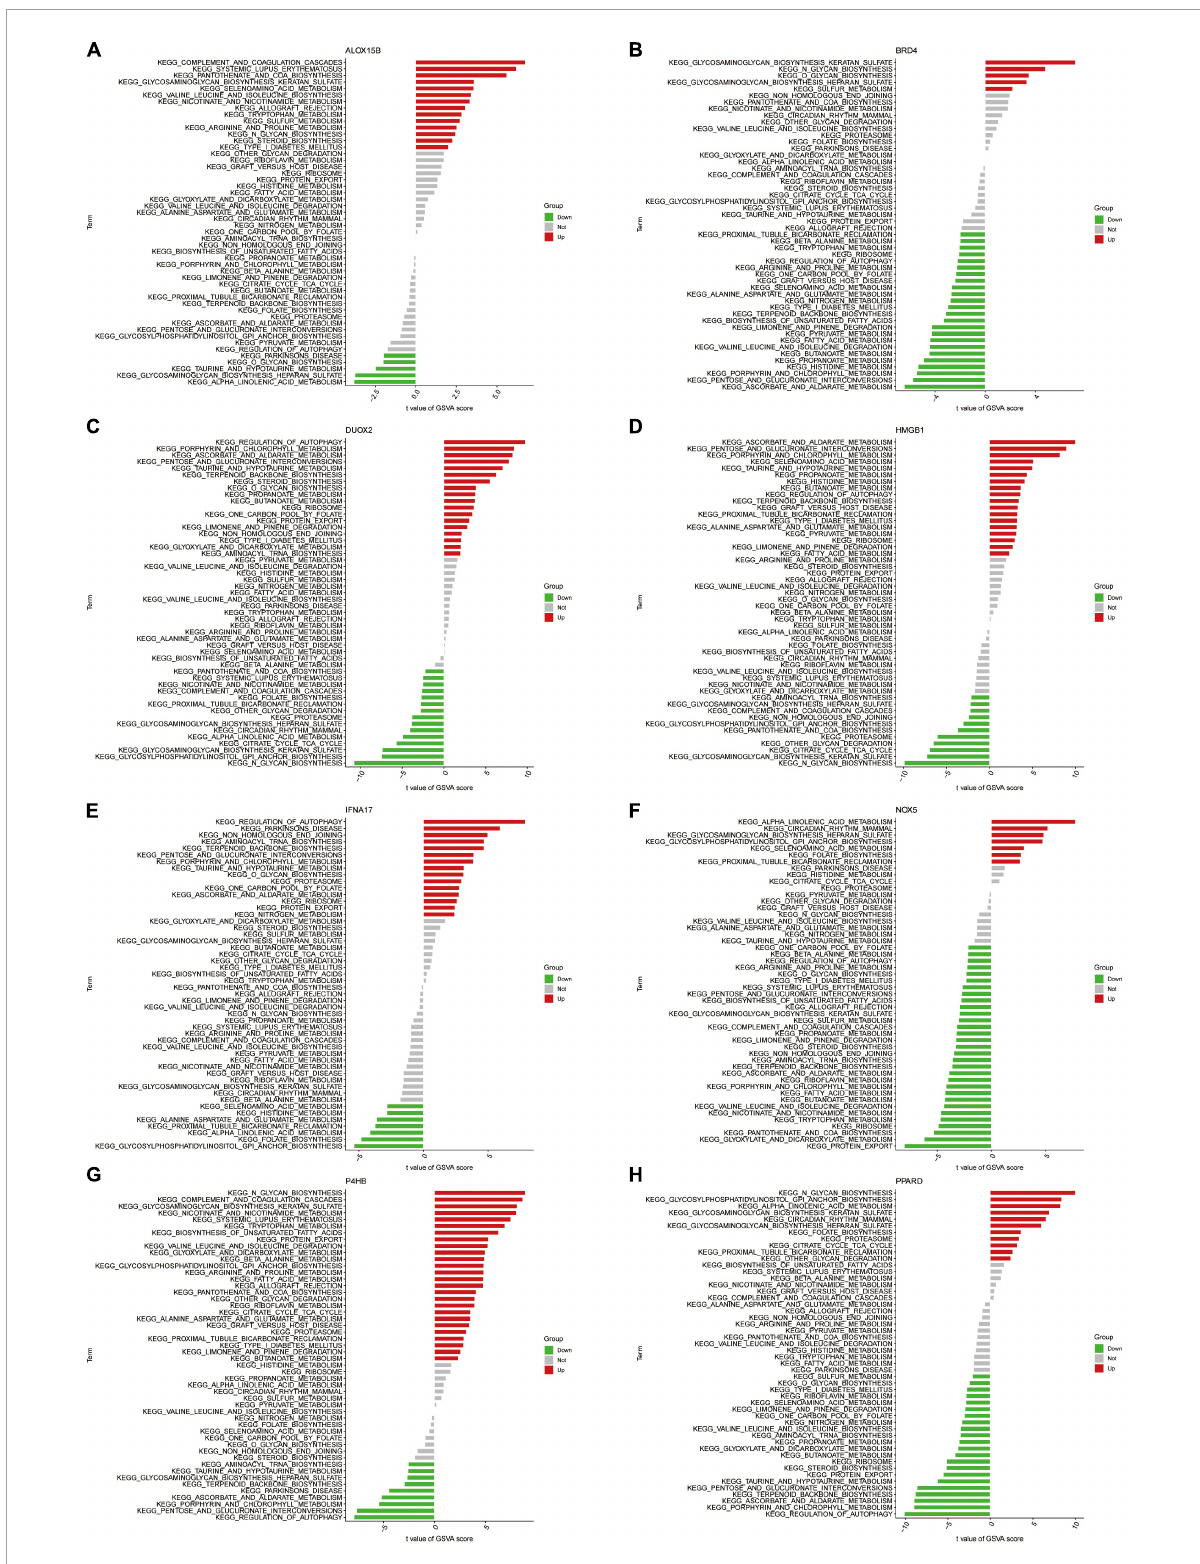
FIGURE10 (A–H) High- and low-expression groups based on the expression levels of each marker gene combined with GSVA in ALOX15B (A) , BRD4 (B) , DUOX2 (C) , HMGB1 (D) , IFNA17 (E) , NOX5 (F) , P4HB (G) , PPARD (H)